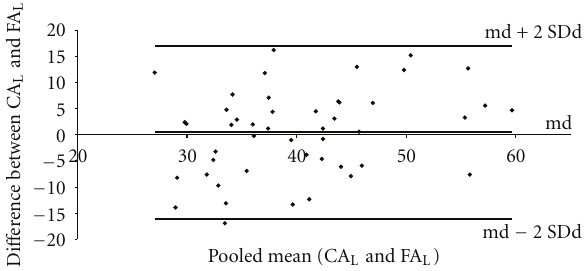
Figure 8: Graphical representation of the degree of agreement in relation to the di ff erence between CA L and FA L in function of the pooled mean (CA L and FA L ). The lumbar curvature mean of di ff erences (md) = 0.5 ◦ , the Standard Deviation of di ff erence (SDd) = 8.3 ◦ , and the limits of agreement are from − 16.0 to +17.0 ◦